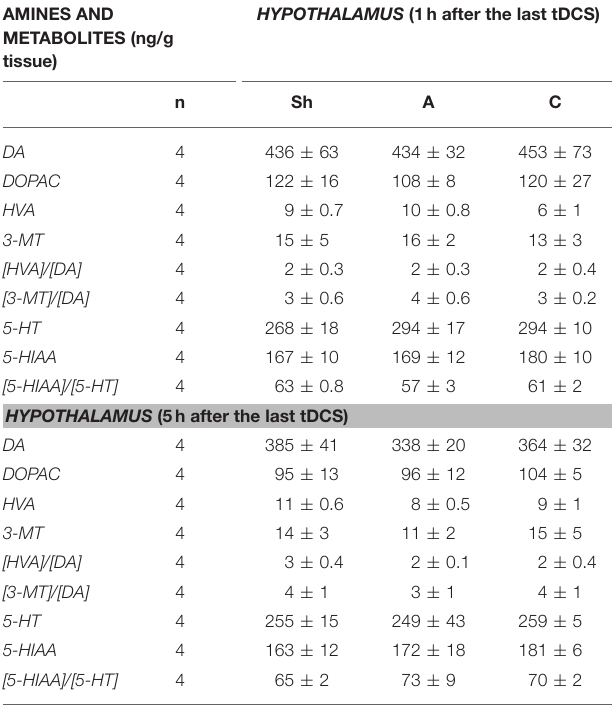
TABLE 7 | The effect of repetitive anodal (A) and cathodal (C) tDCS on the concentration of monoamines (DA, and 5-HT), their metabolites and on the rate of metabolism at different time point after the last stimulation investigated in HYPOTHALAMUS. AMINES AND METABOLITES